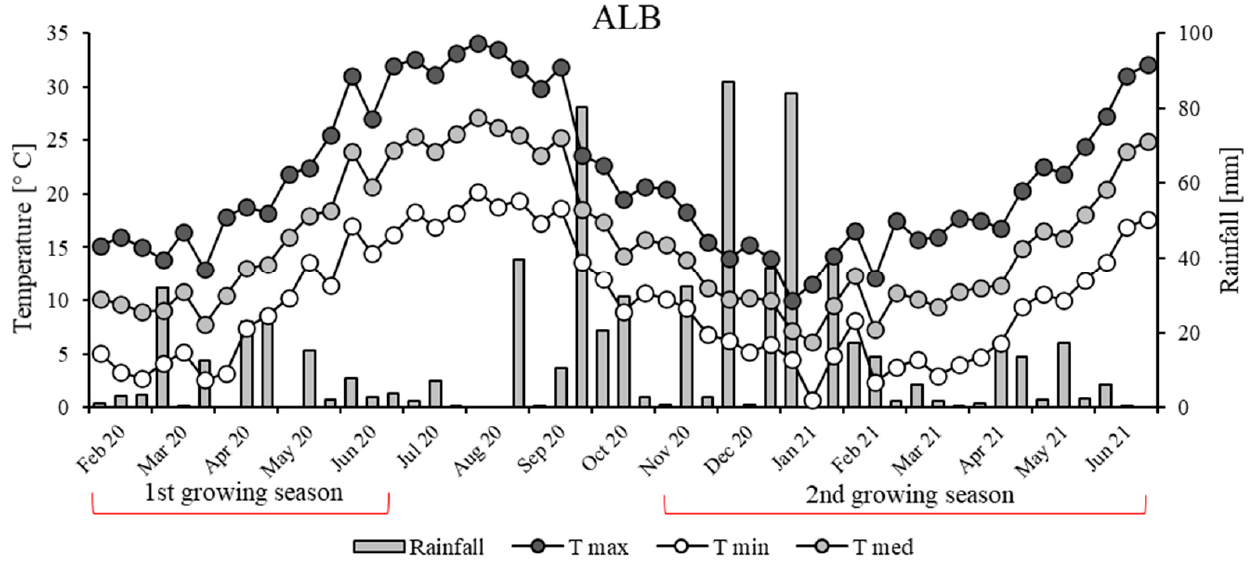
Figure 1. Monthly rainfall and mean, minimum, and maximum temperatures for the entire trial period at Alberese (ALB), Grosseto.